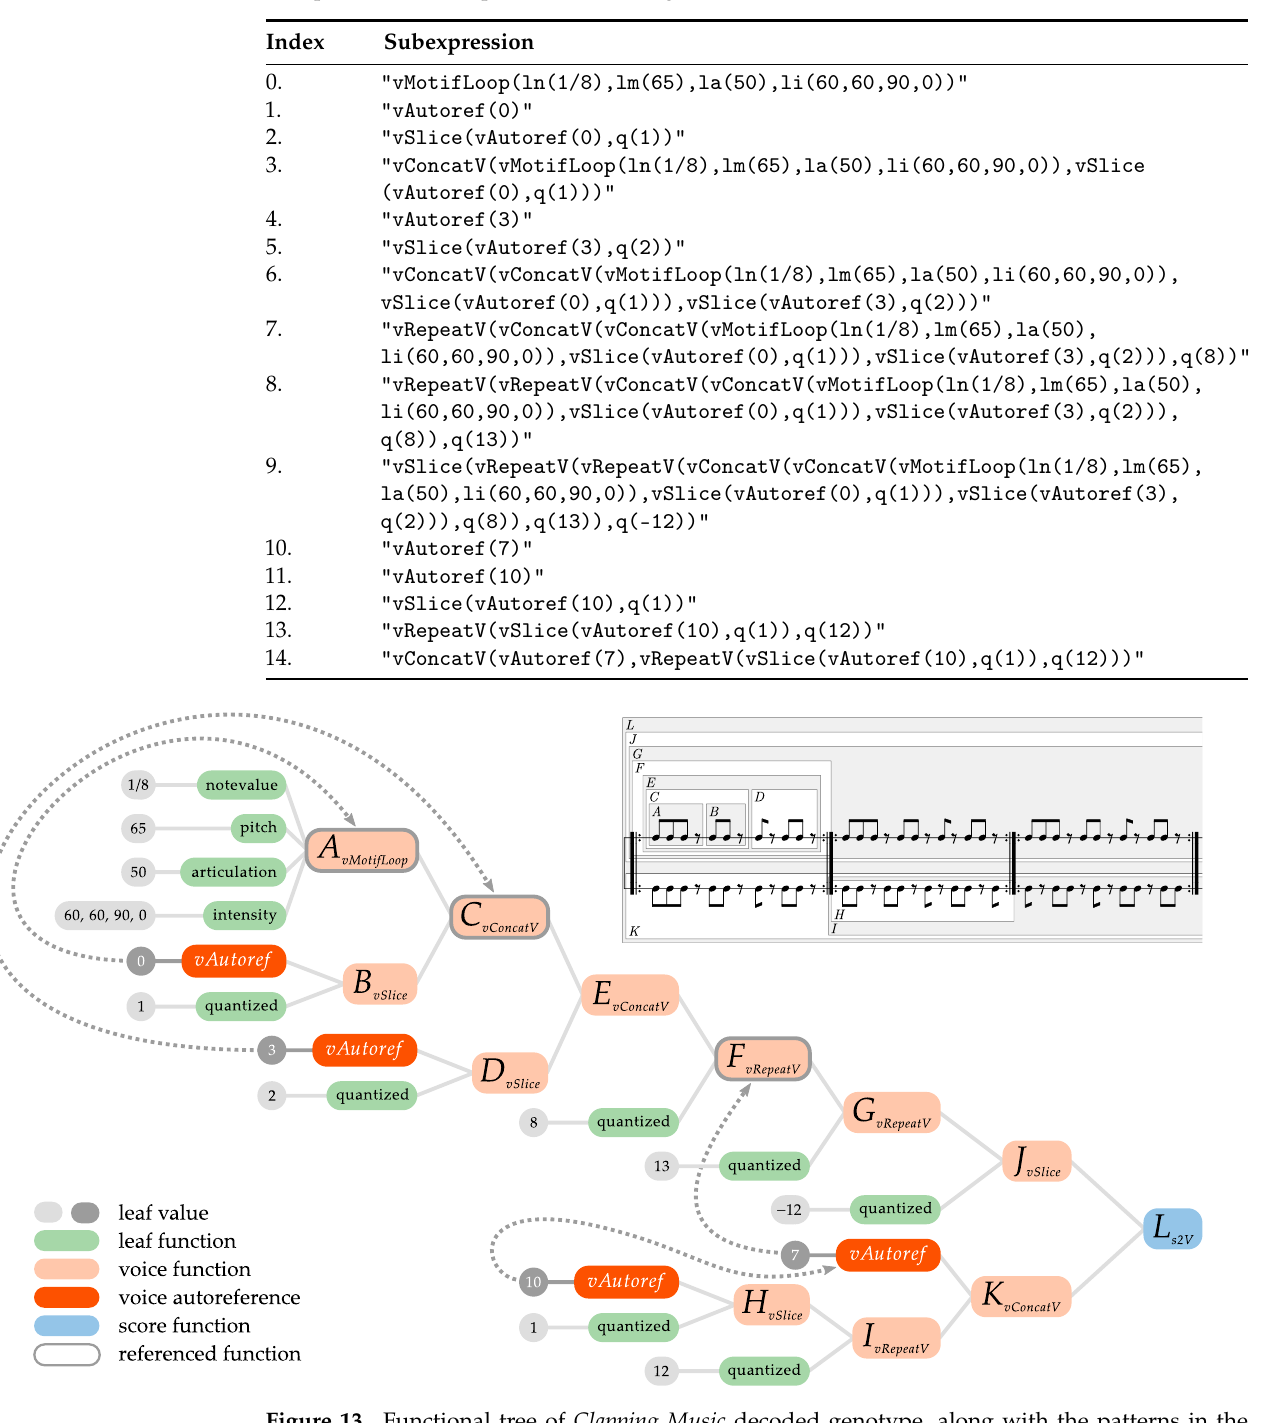
Table 5. Subexpressions of voice function type stored during the evaluation of Clapping Music genotype, available to be pointed by internal autoreferences with function vAutoref . Only voice type subexpressions are shown, although they exist for other categories too. Autoreferences can refer to foregoing autoreferences, as occurs at line 25, where vAutoref(10) points to vAutoref(7) , which in turn points to a subexpression containing two more autoreferences.